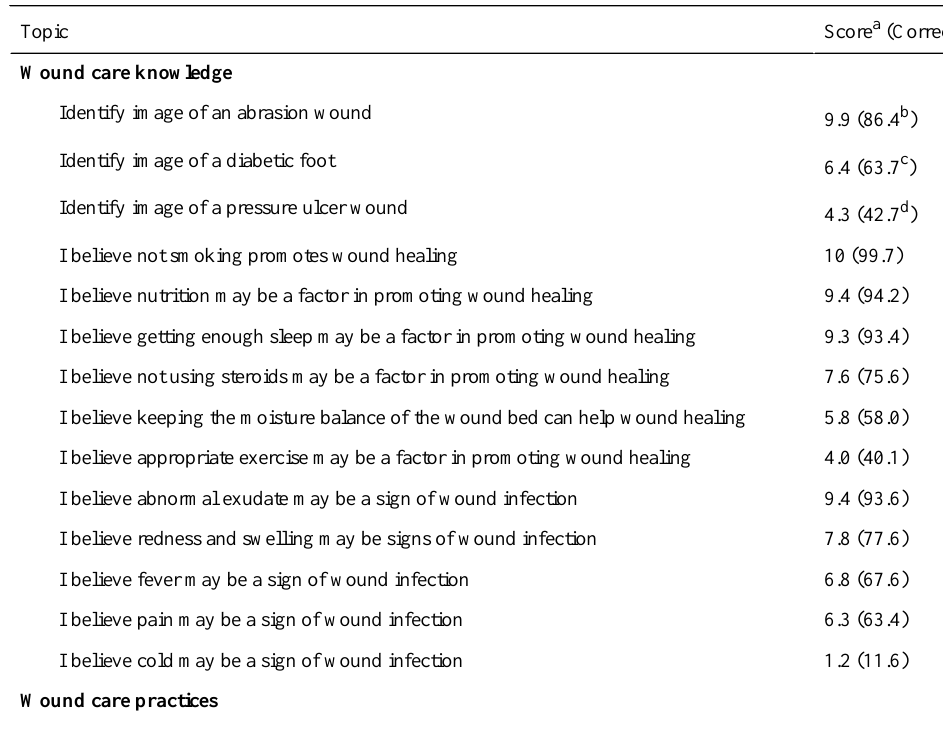
Table 3. Wound care knowledge and practices